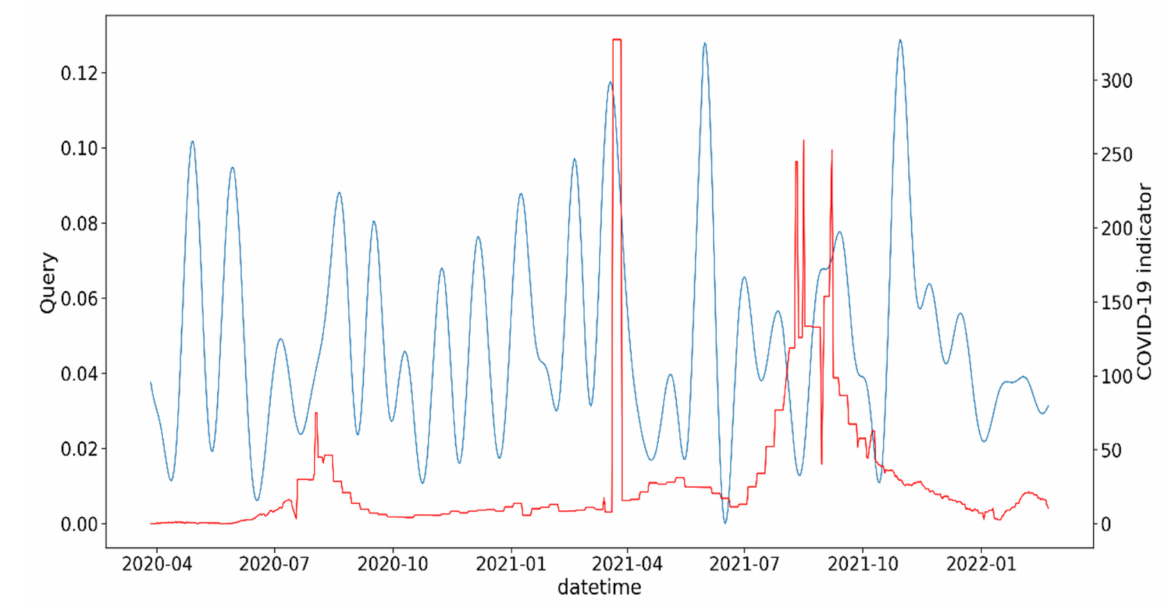
Figure A13. COVID-19 indicator—New deaths. Query—poverty hunger homeless.